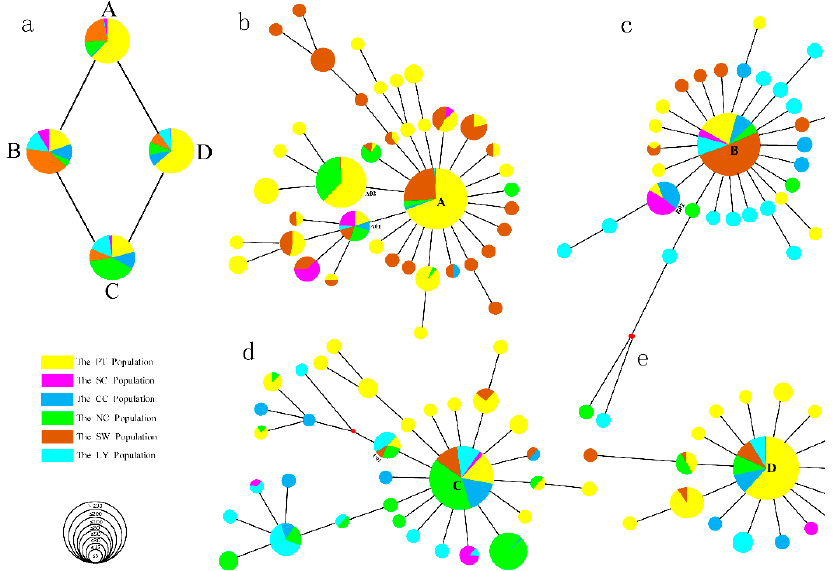
Figure 1. ( a ) A total of 2466 mitochondrial DNA (mtDNA) samples of native pigs representing 124 haplotypes were assigned to four clades (clades A, B, C, and D) in a reduced median network. ( b ) Clade A distribution trend; ( c ) clade B distribution trend; ( d ) clade C distribution trend; ( e ) clade D distribution trend. Most of the samples were from pigs from six different geographical regions of China: North China (NC); the lower Yangtze River Basin (LY); Central China (CC); South China (SC); the southwest (SW); and the plateau (PT). The different regions are represented by different colors. Circle size indicates the number of populations, except in ( a ) A red dot represents a single mutation